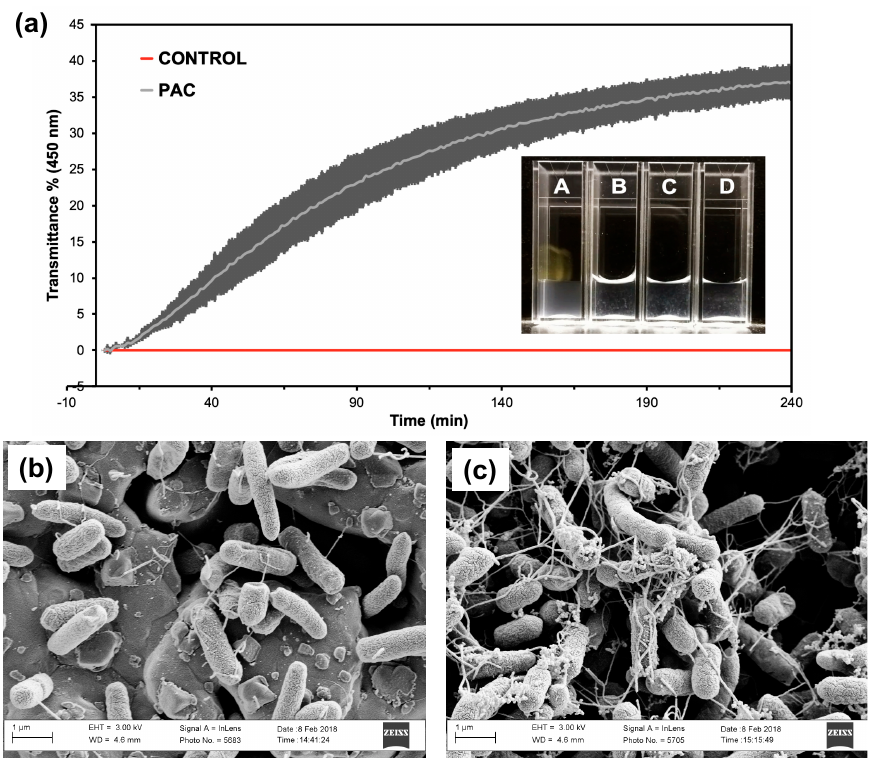
Figure 3. ( a ) UV–vis transmittance vs agglutination time for ExPEC (5.0 × 10 8 CFU/mL) treated with and without cranberry PAC (200 μ g/mL); dark grey area represents standard deviation values (n = 3). Inset: photograph of ( A ) control sample, in which ExPEC are dispersed and ( B – D ) PAC-treated (200 μ g/mL) sample replicates, in which ExPEC are agglutinated and settling. SEM micrographs showing the surface morphology of ( b ) control, without PAC, and ( c ) PAC-treated (200 μ g/mL) ExPEC, showing dense and entangled bacterial fimbrial tip structures.